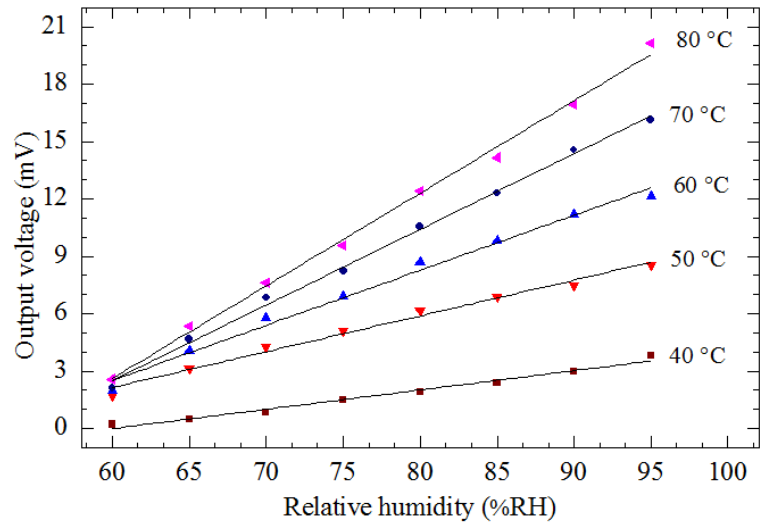
Figure 9. Output voltage vs. relative humidity at various applied voltages from 2 V pp to 6 V pp (corresponding to different operating temperatures from 40 °C to 80 °C) at a constant frequency of 2